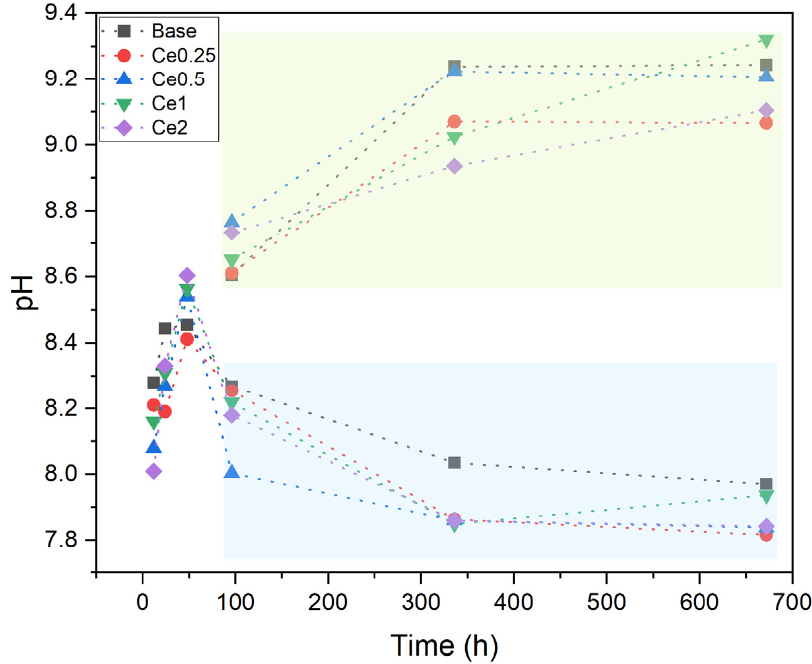
Figure 5. pH values of SBF medium after immersion of all samples in EDS for 12 h, 24 h, 48 h, 96 h, 336 h, and 672 h with medium change every two days (blue rectangle) and without medium change (green rectangle).